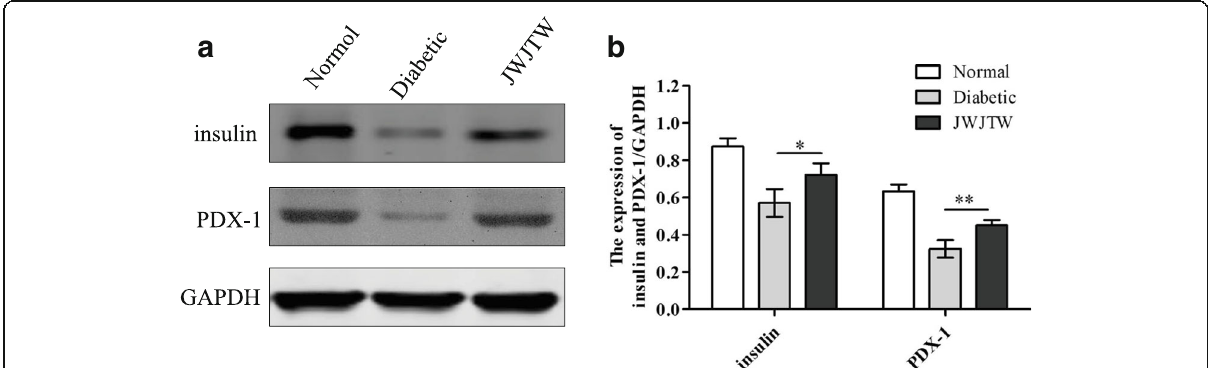
Fig. 7 Effects of JWJTW on insulin and PDX-1 protein expression in pancreatic islets of rats. a Western blot analysis of insulin and PDX-1 expression in pancreatic islets. b Bar graph of the signals for insulin and PDX-1. * p <0.05, ** p< 0.01 ( n